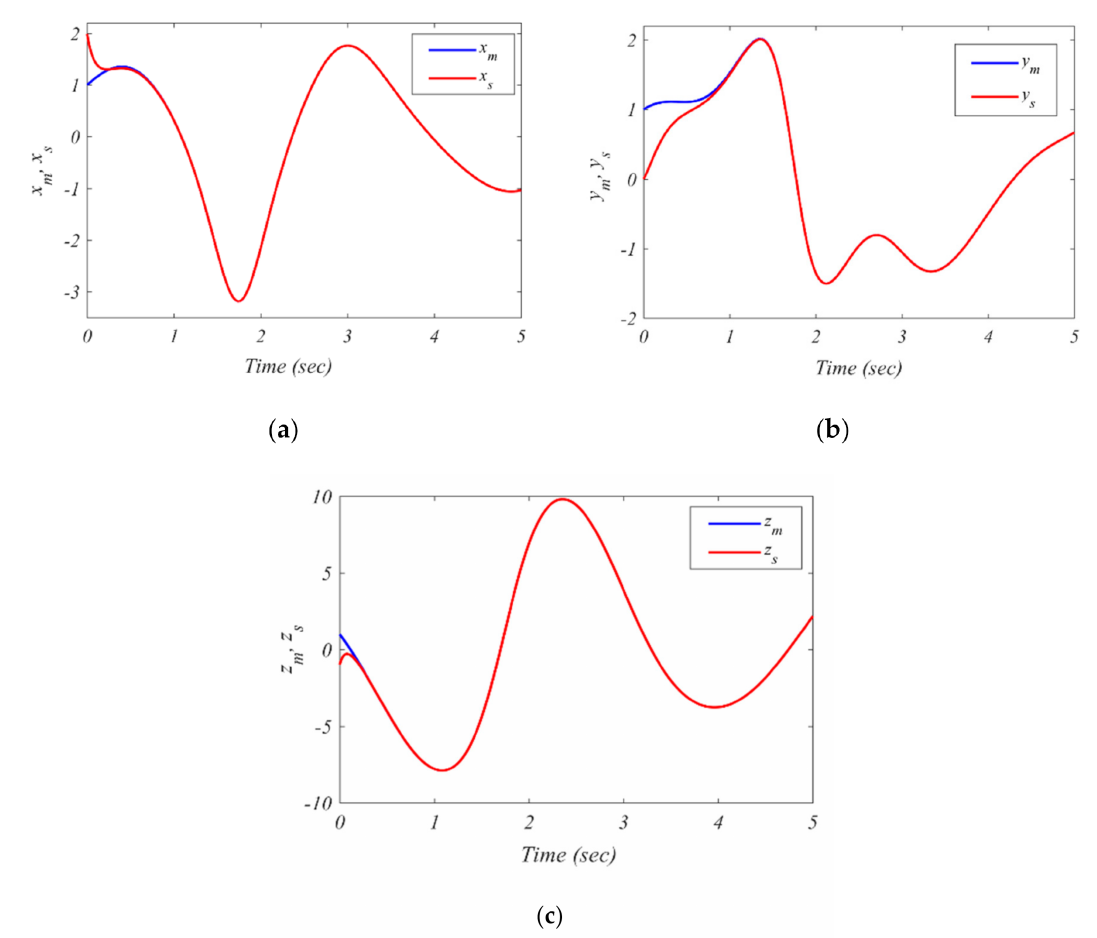
Figure 7. Tracking the slave trajectories corresponding to master trajectories; ( a ) x s track x m ; ( b ) y s track y m ; ( c ) z s track z m .